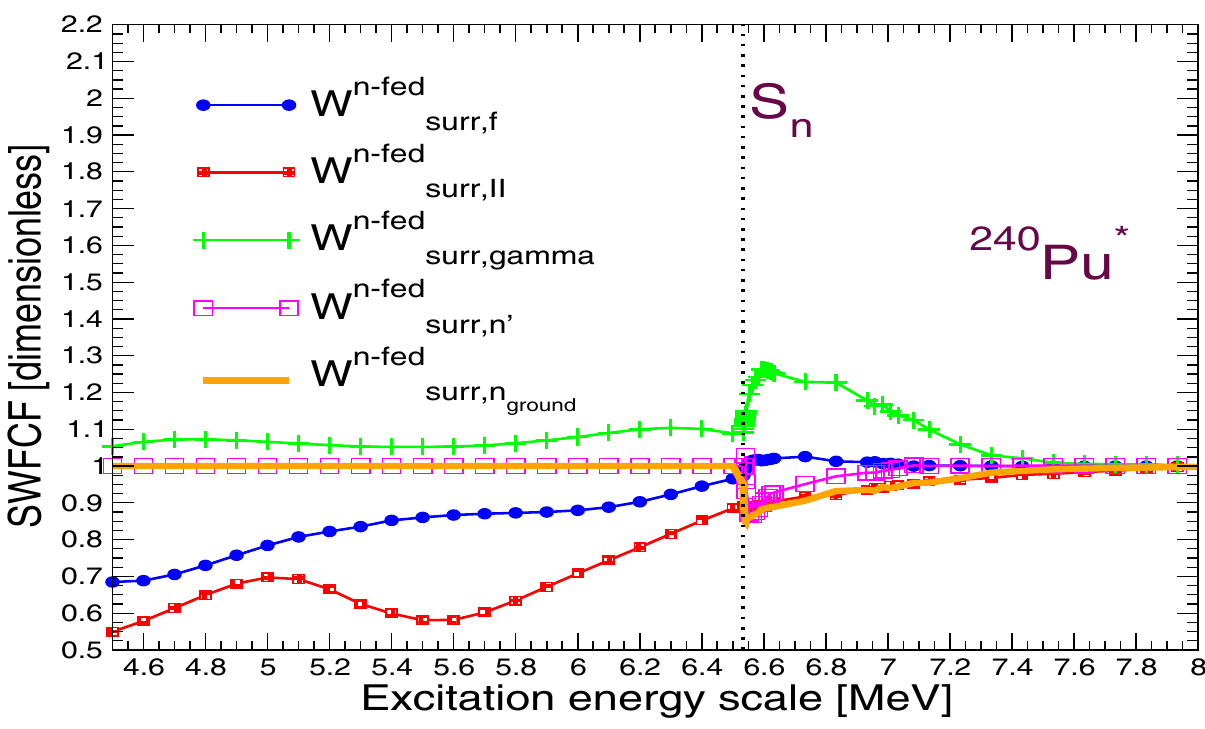
Figure 1. (Color online) Comparison of SWFCF curves associated to fission ( W surr , f ), γ decay ( W surr ,γ ) and neutron emission with ) or in excited states ( W surr , n ′ ) according to surrogate reactions for the 240 Pu ∗ over the residual nucleus in ground state ( W surr , n g round whole excitation energy range. W surr , II is a specific correction for the statistical fluctuations of the widths of the class-II states lying in the second well of a double-humped fission barrier. The various SWFCF displayed must be seen as global coe ffi cients related to each partial reaction but integrated over all J π compound system excited states. For easier visualization, they are calculated with the neutron-incident excited-state population; (n-fed)